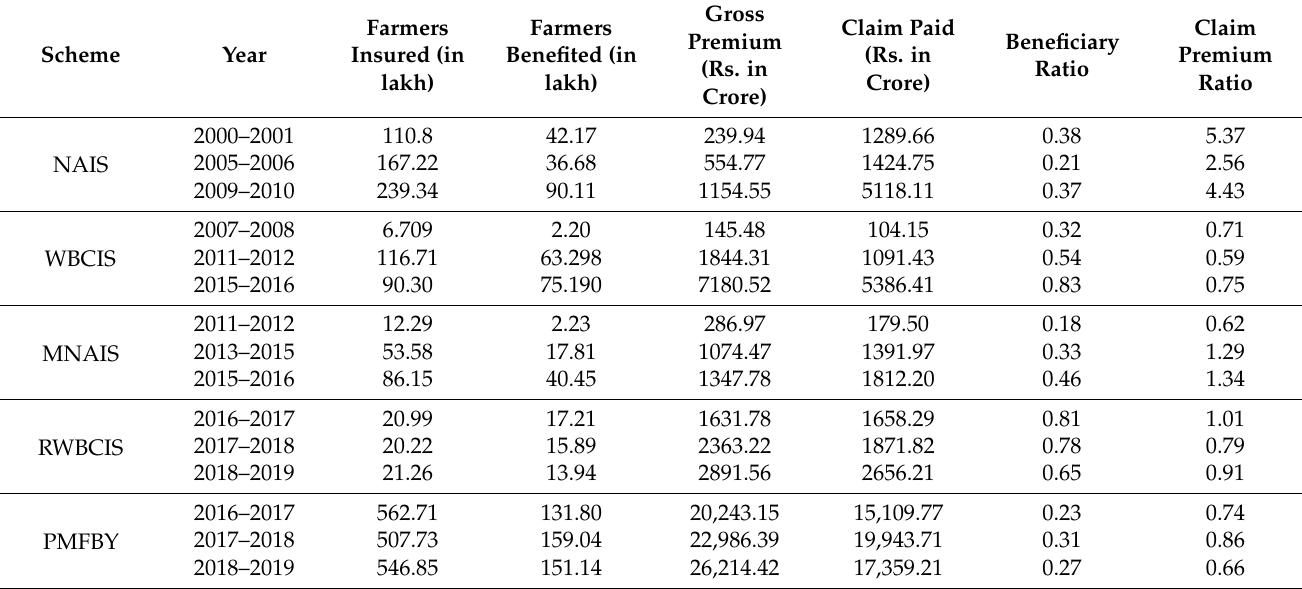
Table 6. Assessment of various crop insurance schemes in India (2000–2019).